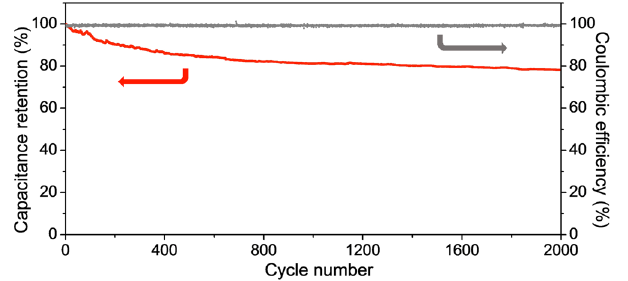
Figure 8. The capacitance retention and coulombic efficiency of SnO 2 @C@half-rGO//gpC LIHC for 2000 cycles at 1.0 A g − 1